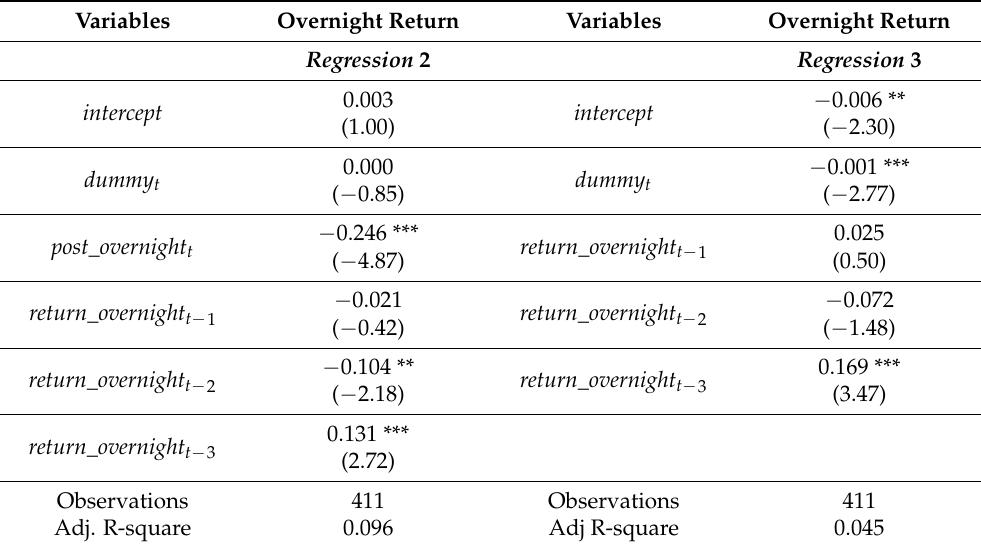
Table 8. Further analysis of overnight return against investor attention. This table presents the results of the Regression 2 and 3 on overnight return on posts. The results in this table are comparable to those in Table 7. The dependent variable is the overnight return. The variable dummy is an indicator of negative daytime return ( dummy = 1 for negative daytime returns, and 0 otherwise). The variable post_overnight t is only included in Regression 2. The lagged returns control for existing information in the